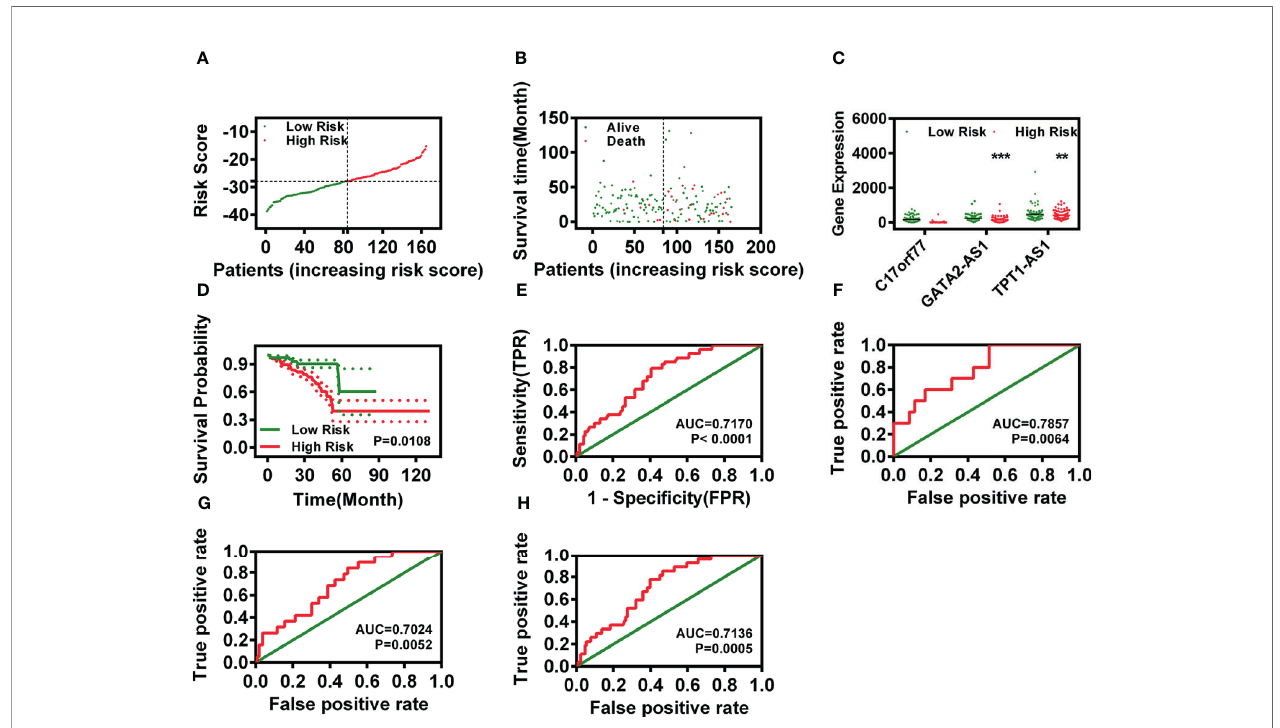
FIGURE 2 | Risk assessment model construction based on three signature DELs. (A, B) Risk scores (A) and survival outcome (B) of each case for READ. (C) The expression of C17orf77, GATA2-AS1, and TPT1-AS1 between low- and high-risk groups. (D) Overall survival analysis of the risk model. (E) The ROC curve of the risk model. (F – H) The 1-year (F) , 3-year (G) , and 5-year (H) ROC of the prognosis model suggested that all AUC values were over